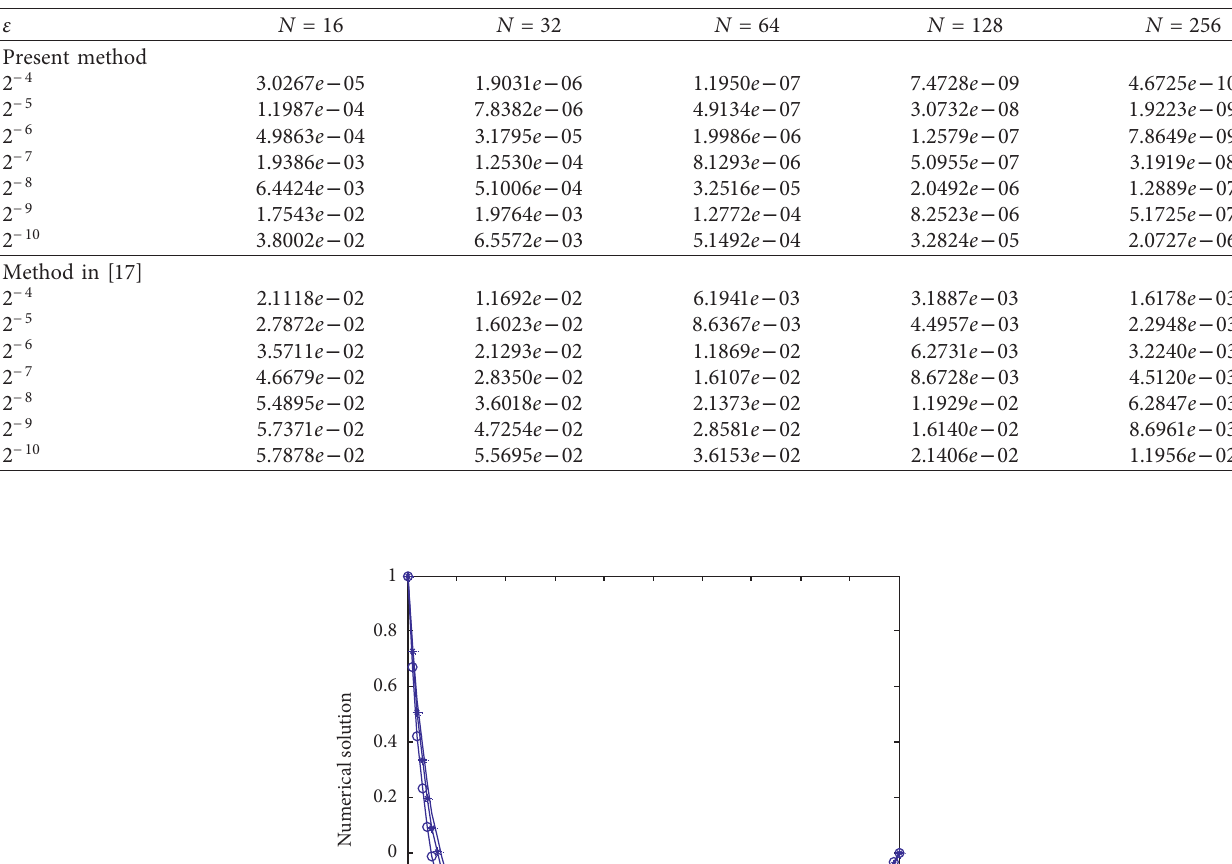
Table 4: The maximum absolute errors of Example 2 for different values of ε with δ � 0 . 5 ε .